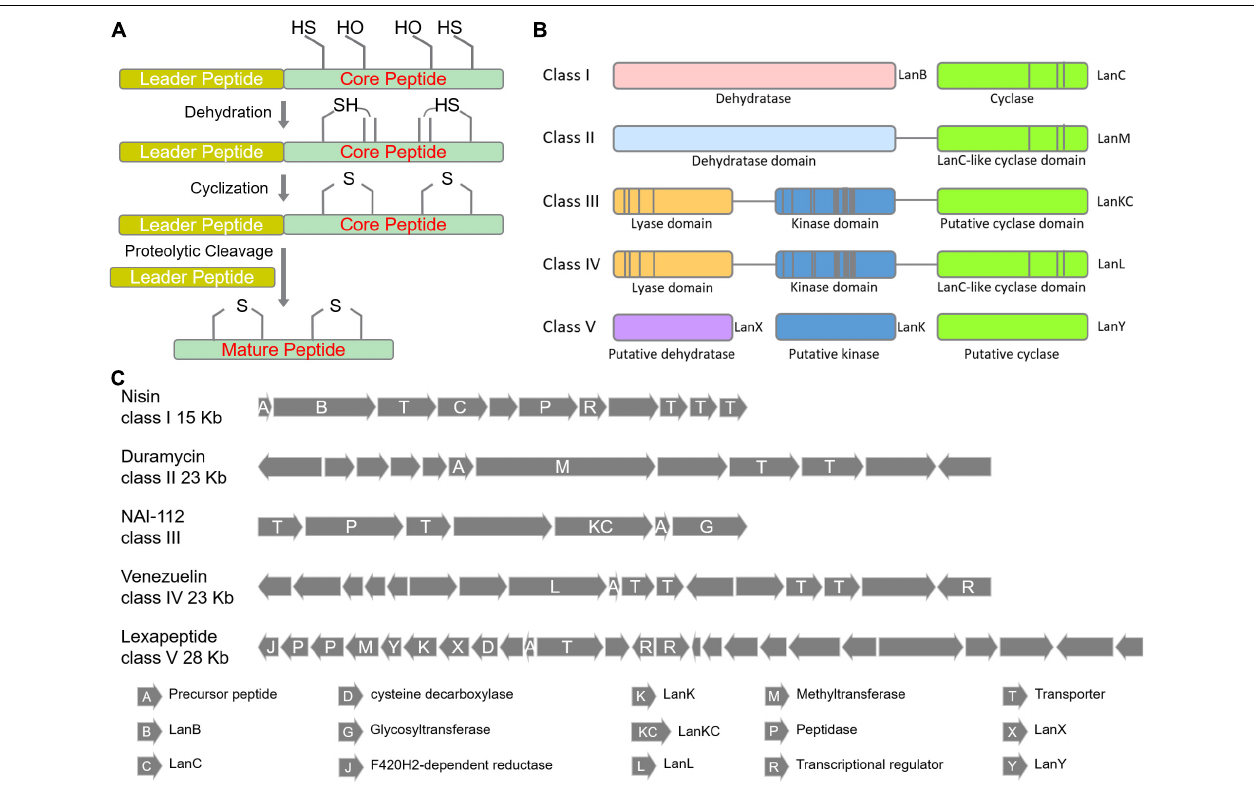
FIGURE 3 | Biosynthetic pathways of lanthipeptides. (A) The general steps of lanthipeptide biosynthesis. (B) Five classes of key enzymes for the formation of thioether ring. (C) Representative BGCs for lanthipeptide